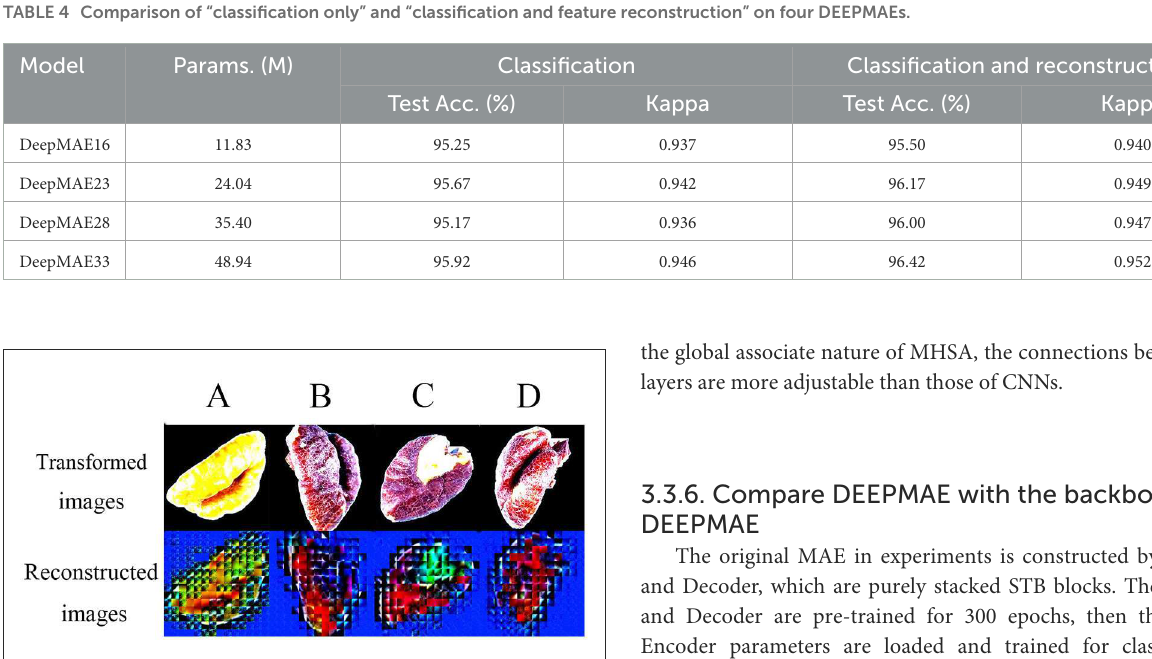
FIGURE8 Examples of reconstructed feature images. In addition, image data must be transformed into tensors before being input into a model in PyTorch. The transformed images are from these